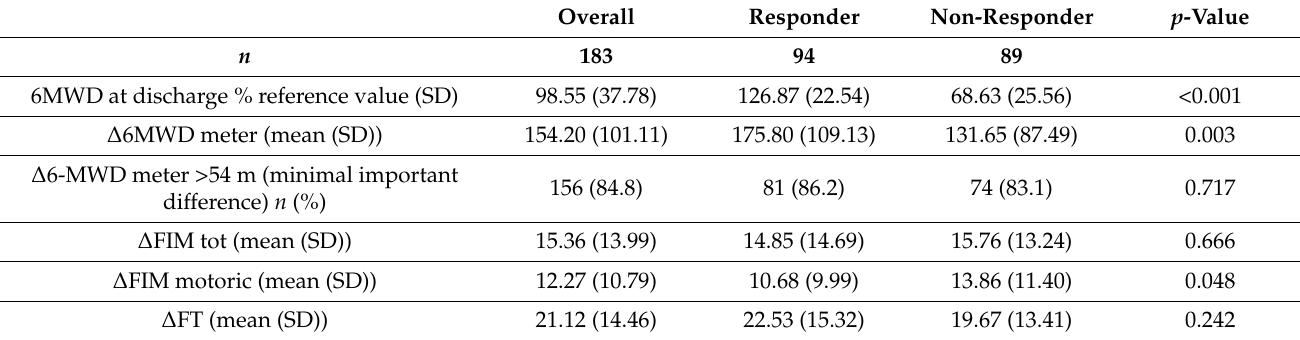
Table 3. PR Results according to 6-MWD, FT and FIM of responders and